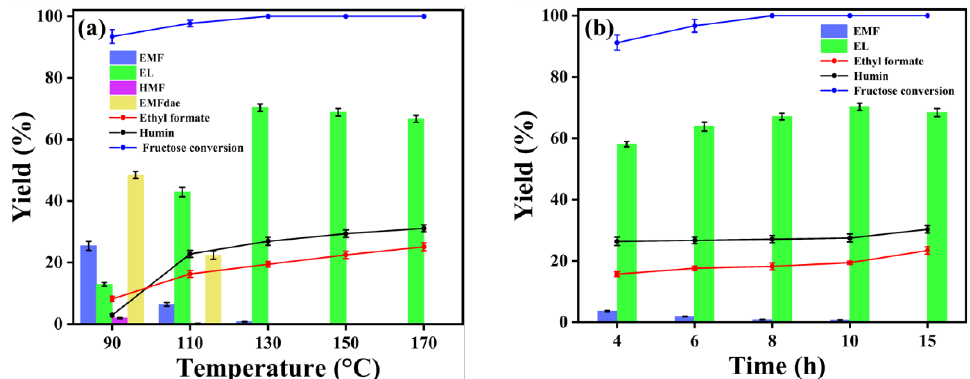
Figure 7. Effects of ( a ) reaction temperature (fructose 180 mg, TPC – S catalyst 50 mg, ethanol 5 mL, 10 h) and ( b ) reaction time (fructose 180 mg, TPC – S catalyst 50 mg, ethanol 5 mL, 130 °C) on EL yield.